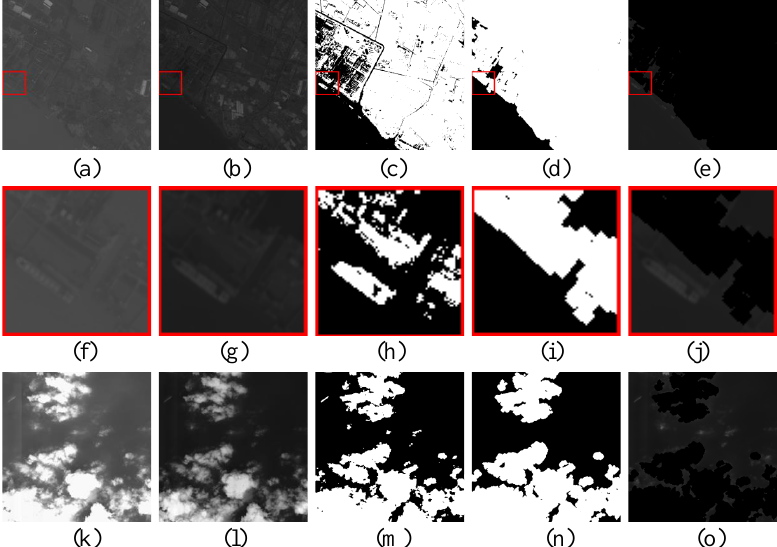
Figure 12. Sea-land segmentation results under complex backgrounds with inshore ships and bright clouds. ( a , k ) are green images; ( b , l ) are NIR images; ( c , m ) denote sea-land binary segmentation; ( d , n ) denote removing small connected regions at sea; ( e , o ) are NIR images without land; ( f – j ) zoom-in regions of the red rectangles in ( a – e